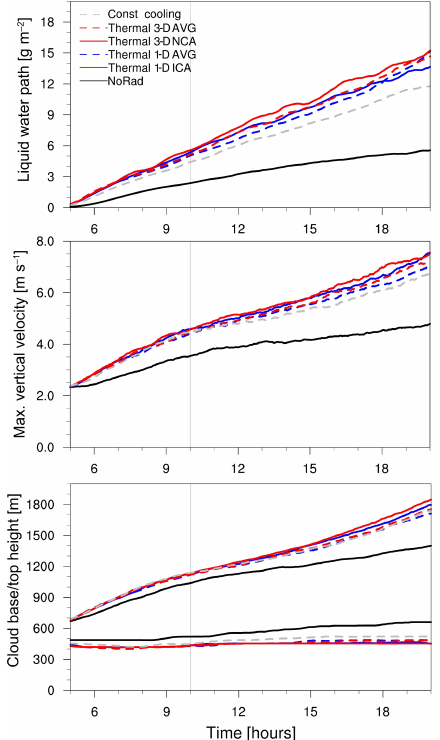
Figure 9. Time development of the liquid water path, maximum vertical velocity and cloud base and cloud top height. The gray line (at 10h) separates the development in different periods for further